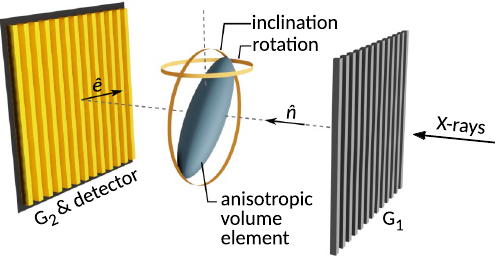
Figure 1. Sketch of a Talbot interferometer imaging an anisotropic volume element. From left to right: Integrating detector pixel with analyzer grating G2, volume element with indicators for the rotations and inclinations referred to in Fig. 2, and the modulating grating G1. The optical axis and orientation of n and e respectively. (Figure adapted from Graetz et al. 11 interferometer sensitivity are indicated by ˆ ˆ